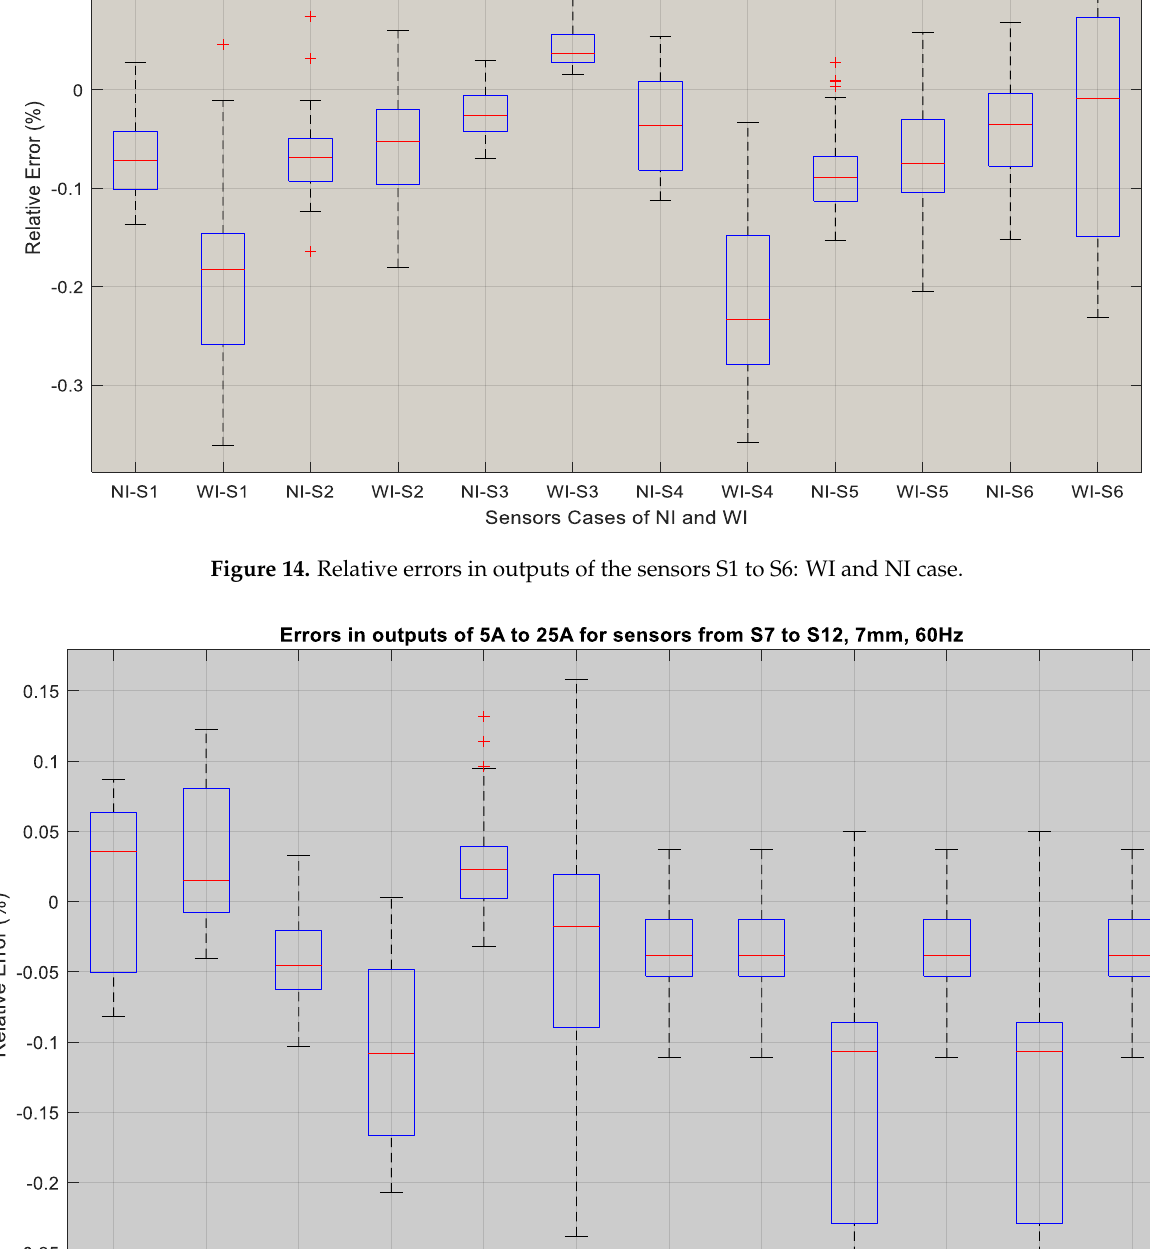
Figure 15. Relative errors in outputs of the sensors S7 to S12: WI and NI case.